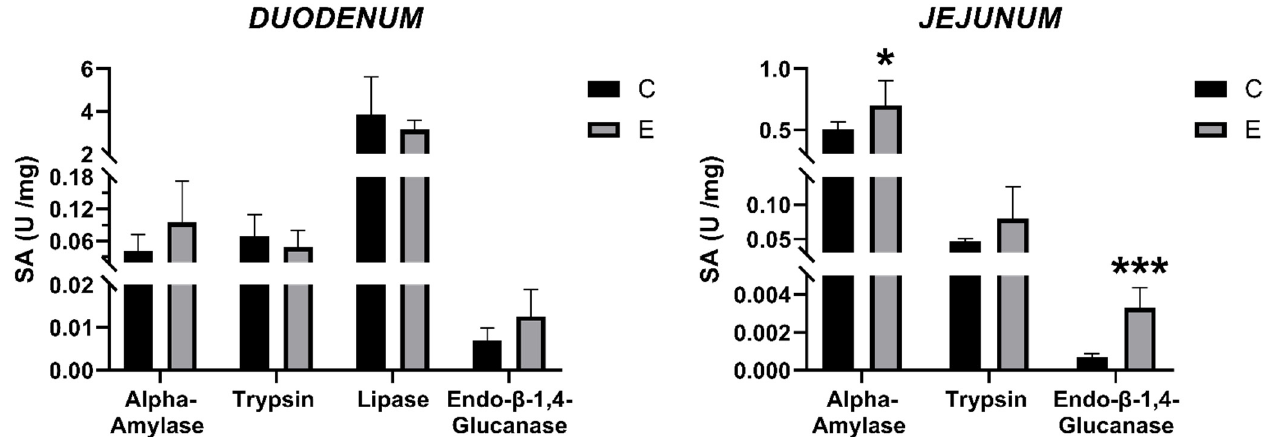
Figure 4. Effect of flaxseed meal supplementation to the basal diet of broiler chickens on the enzymatic specific activity (SA) of alpha-amylase, trypsin, lipase, and endo- β -1,4-glucanase, expressed as units per milligram of protein, from the duodenum and jejunum intestinal contents. All data are reported as mean values ± standard deviation (SD), and statistical significance is indicated as follows: * p ≤ 0.05; *** p ≤ 0.001 ( n = 10).